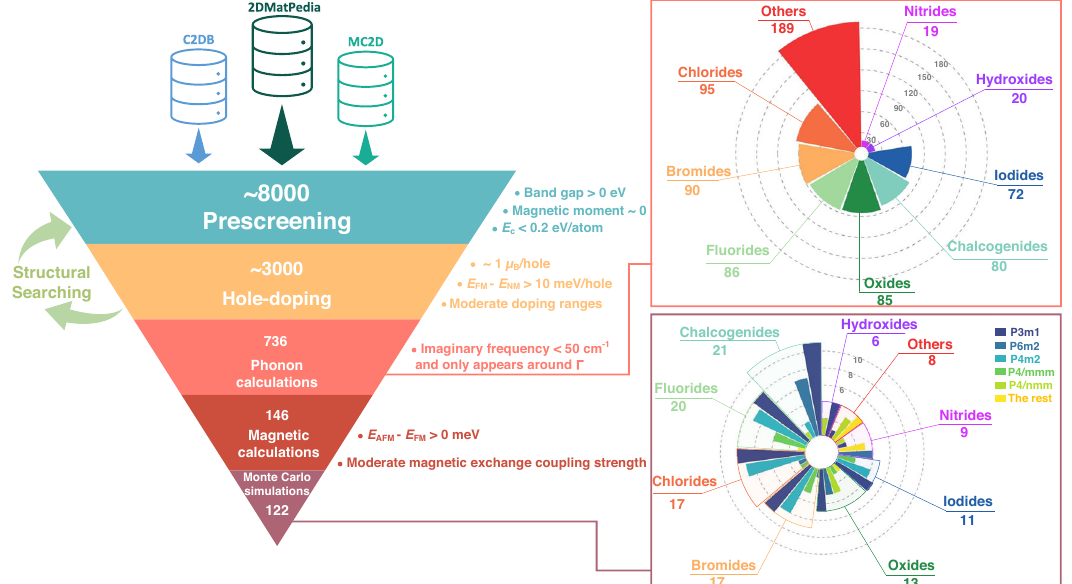
Fig. 1 The work fl ow of the high-throughput screening for 2D hole-doping induced ferromagnetic materials. 2D structures are collected from 2DMatpedia Database, Computational 2D Materials Database (C2DB) and Materials Cloud two-dimensional crystals database (MC2D) to identify potential 2D ferromagnetic materials upon hole doping (left panel). The number of candidate materials and the screening criteria used for each screening step are provided. Polar histogram showing the number of structures belonging to different chemical compositions after hole doping screening (top right panel); Polar histogram displaying the number of fi nal stable 2D ferromagnetic materials in terms of chemical compositions and their crystal space groups (bottom right